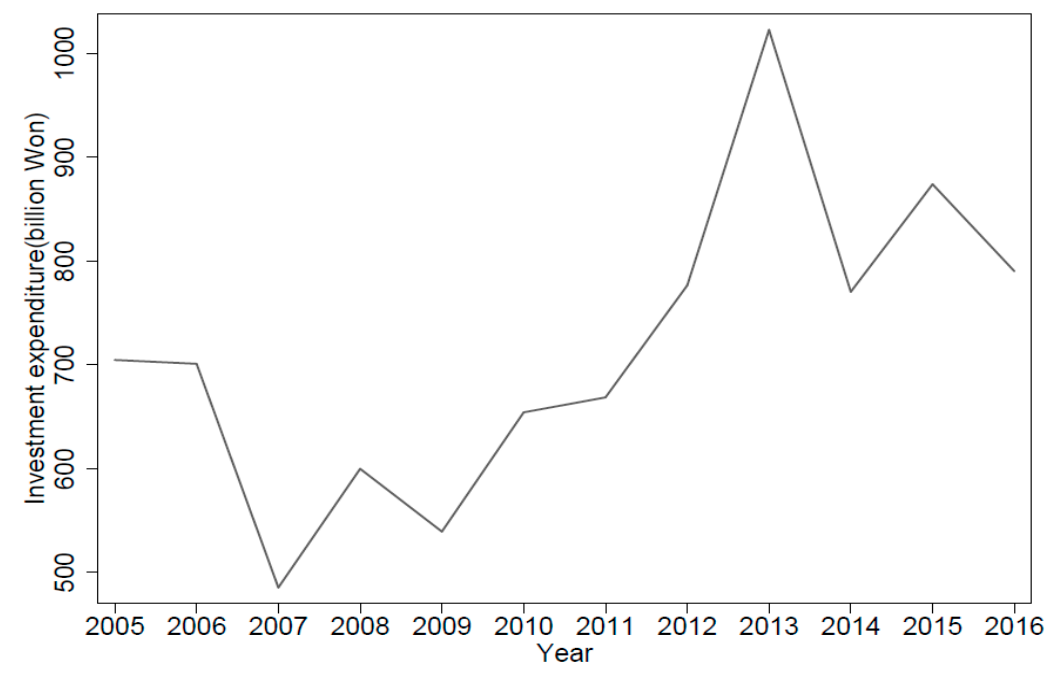
Figure 1. Energy and Environmental Expenditure of Korean Manufacturing (Source: Statistics Korea).